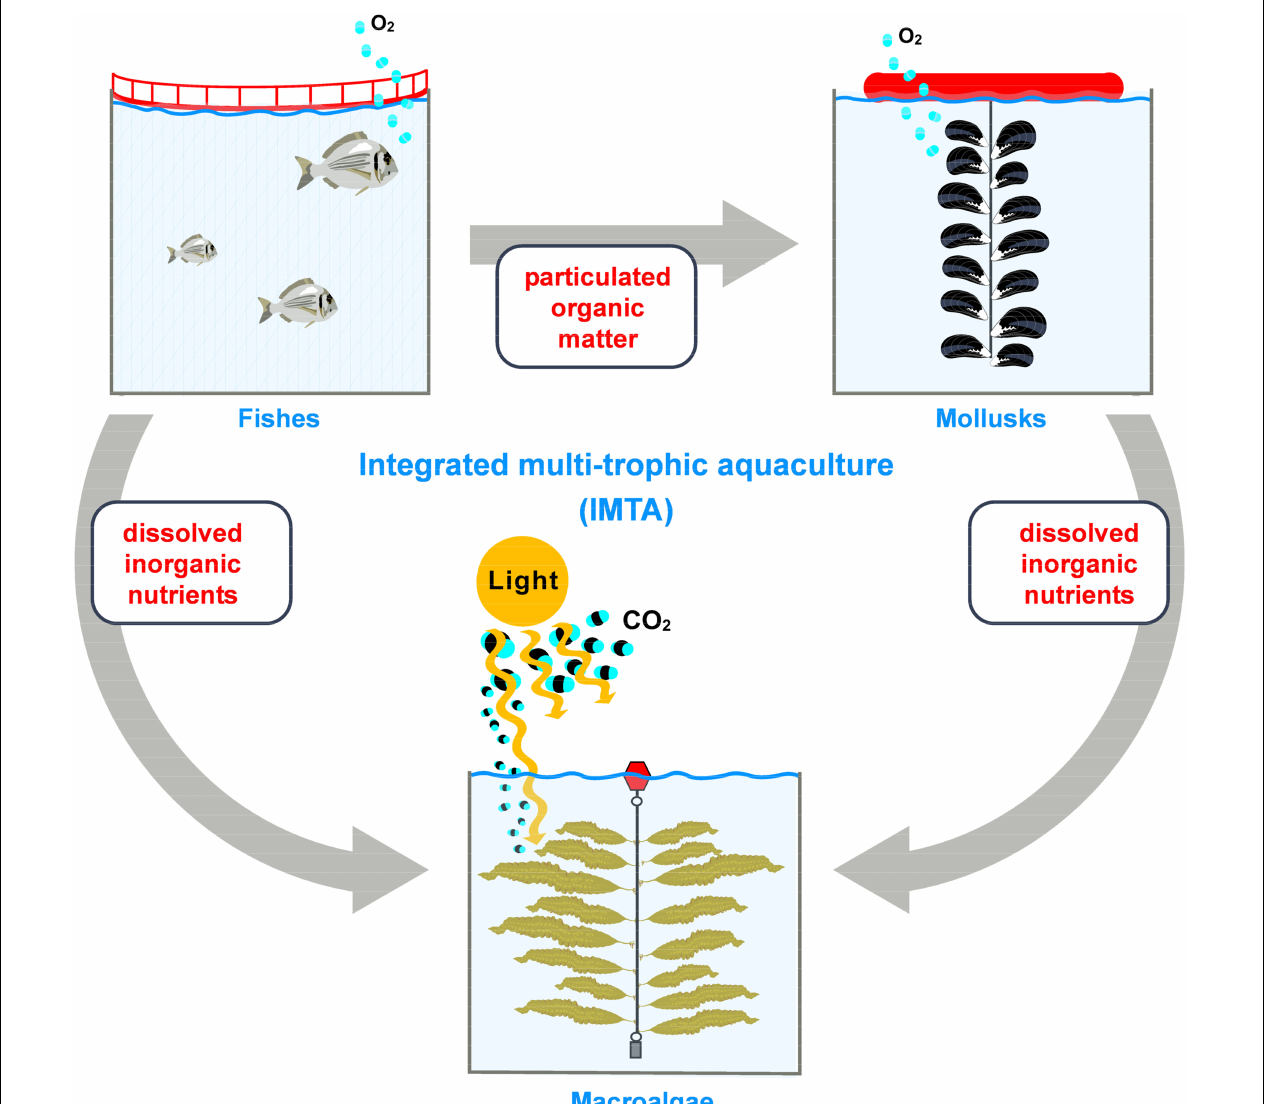
FIGURE 7 | Schematic description of the Integrated Multitrophic Aquaculture (IMTA)